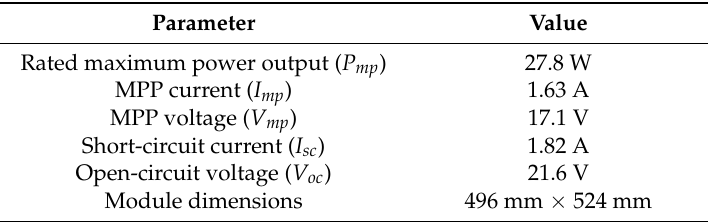
Table 1. Electricity parameter specifications of the SANYO HIP 2717 PV module.